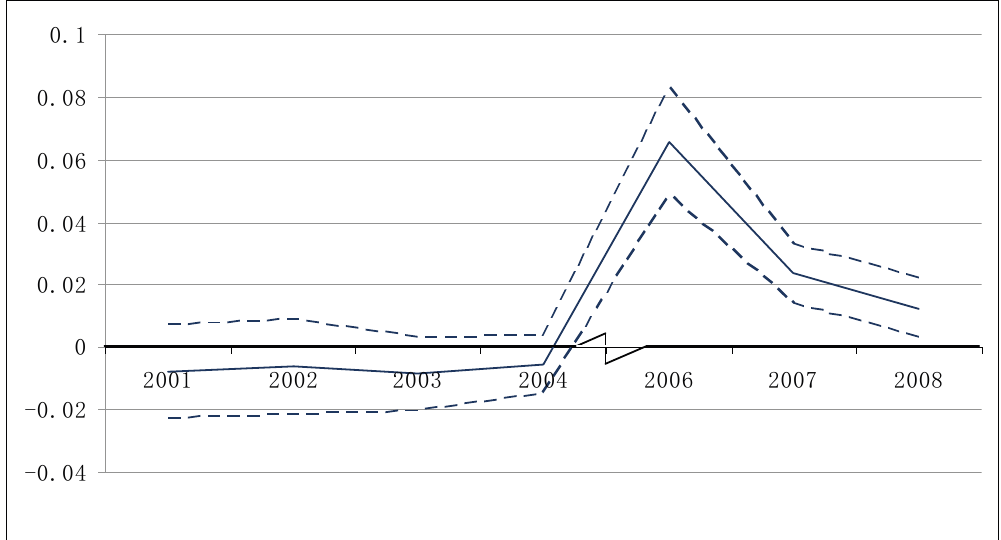
Figure 2. The evolving of evacuees’ likelihood of discipline infraction relative to non-evacuees. Notes: Equation (2) is regressed each year during 2001–2008 except 2005 when Hurricane Katrina happened. Only students whose records exist in 2006 are used in the analysis. The solid line connects estimated β of each year whereas the dashed lines form 95% confidence interval of each estimated β